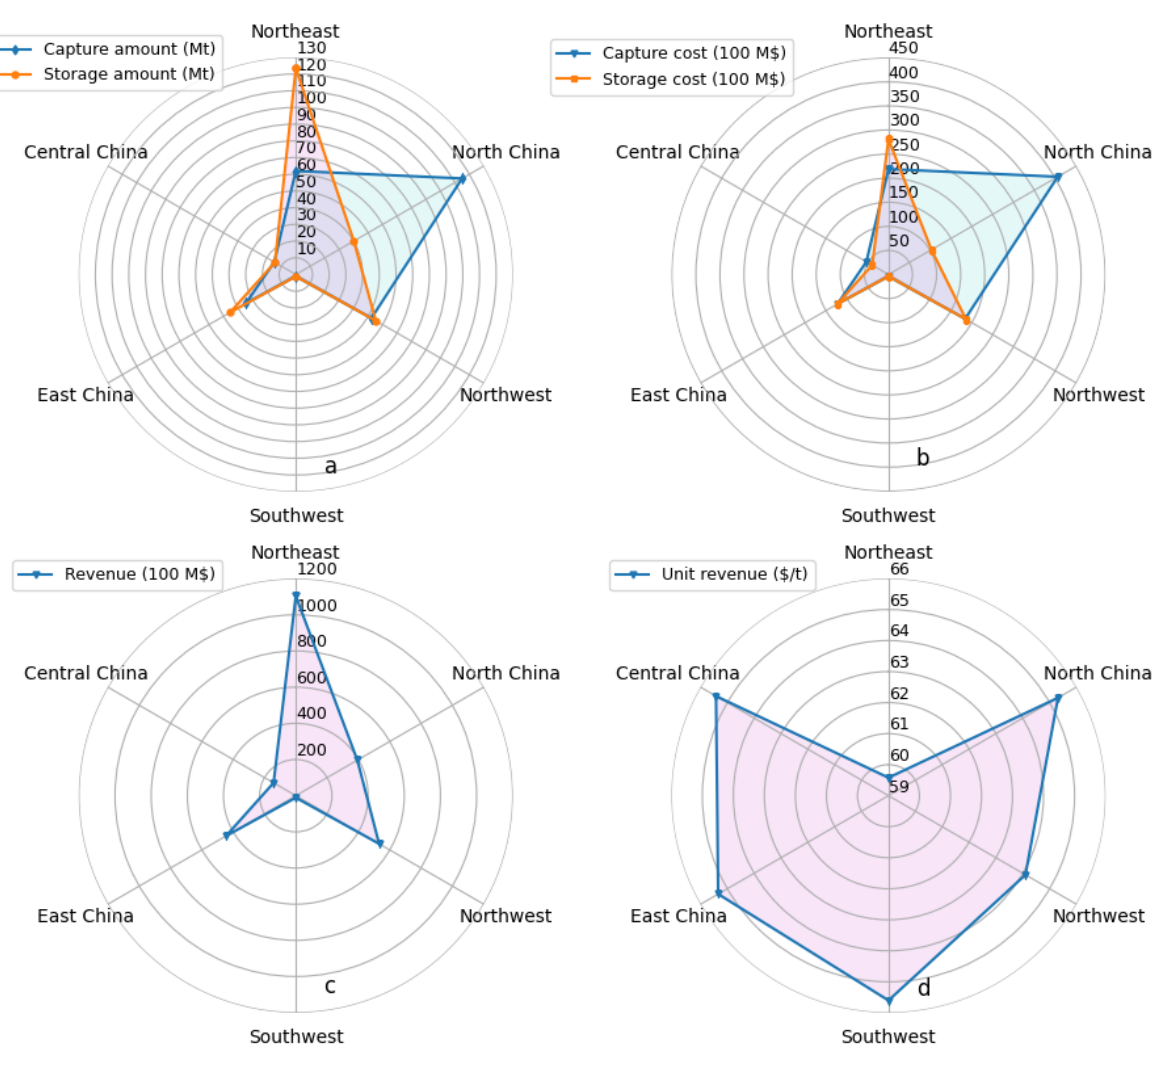
Figure 5. Regional annual capture, storage volume, capture cost, storage cost, total storage revenue, and average storage revenue. ( a ) shows the amount of capture and storage in each region, ( b ) shows the cost of capture and storage in each region, ( c ) shows the EOR revenue in each region, and ( d ) shows the unit storage revenue in each region.